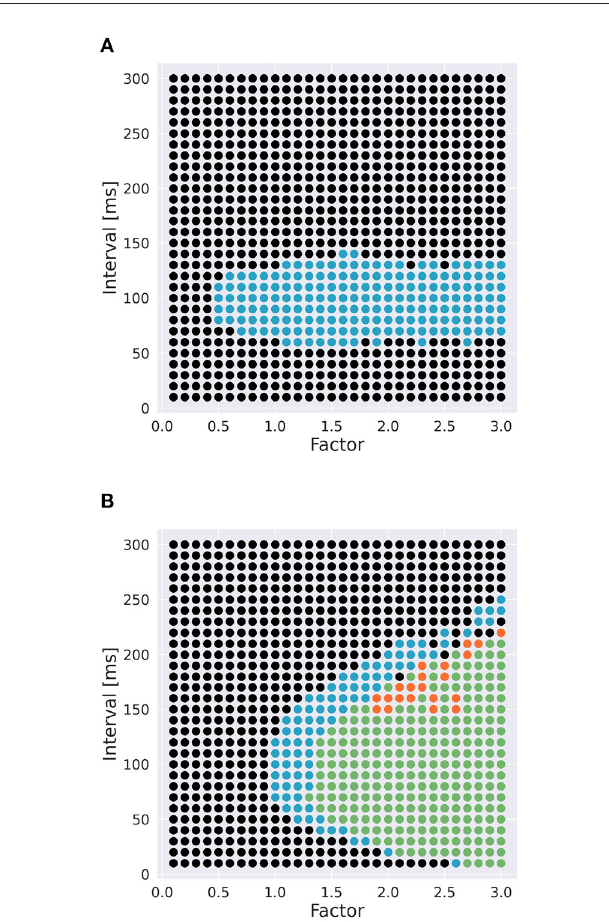
FIGURE7 Effect of time constants of Ca 2 + channels [ (A) : CaP channel; (B) : CaT channel] and interval on sequence discrimination. Time constants were multiplied by a factor f (Figure 3). Colors are the same as in Figure 5. The number of pulses was 6, and synaptic weight was 6.633